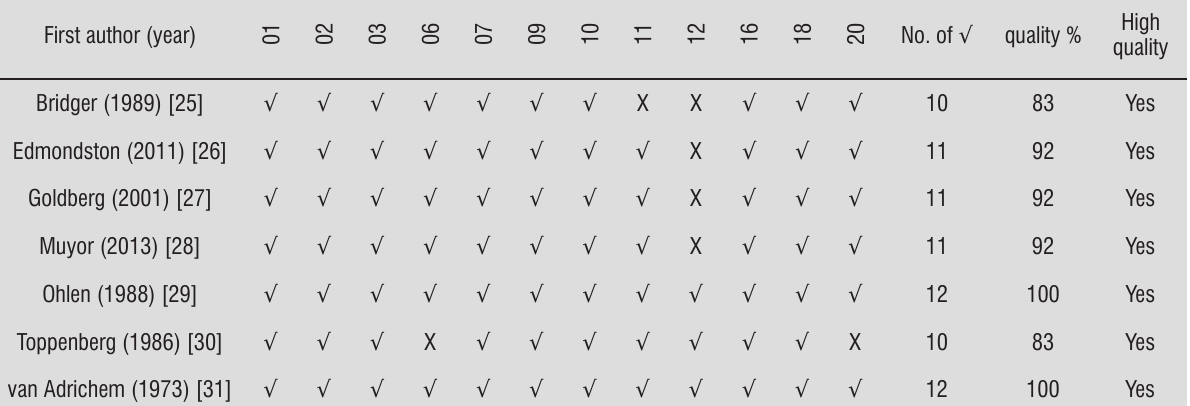
Table 2 - Scoring and score of each study in the methodological quality evaluation by the Downs & Black scale First author